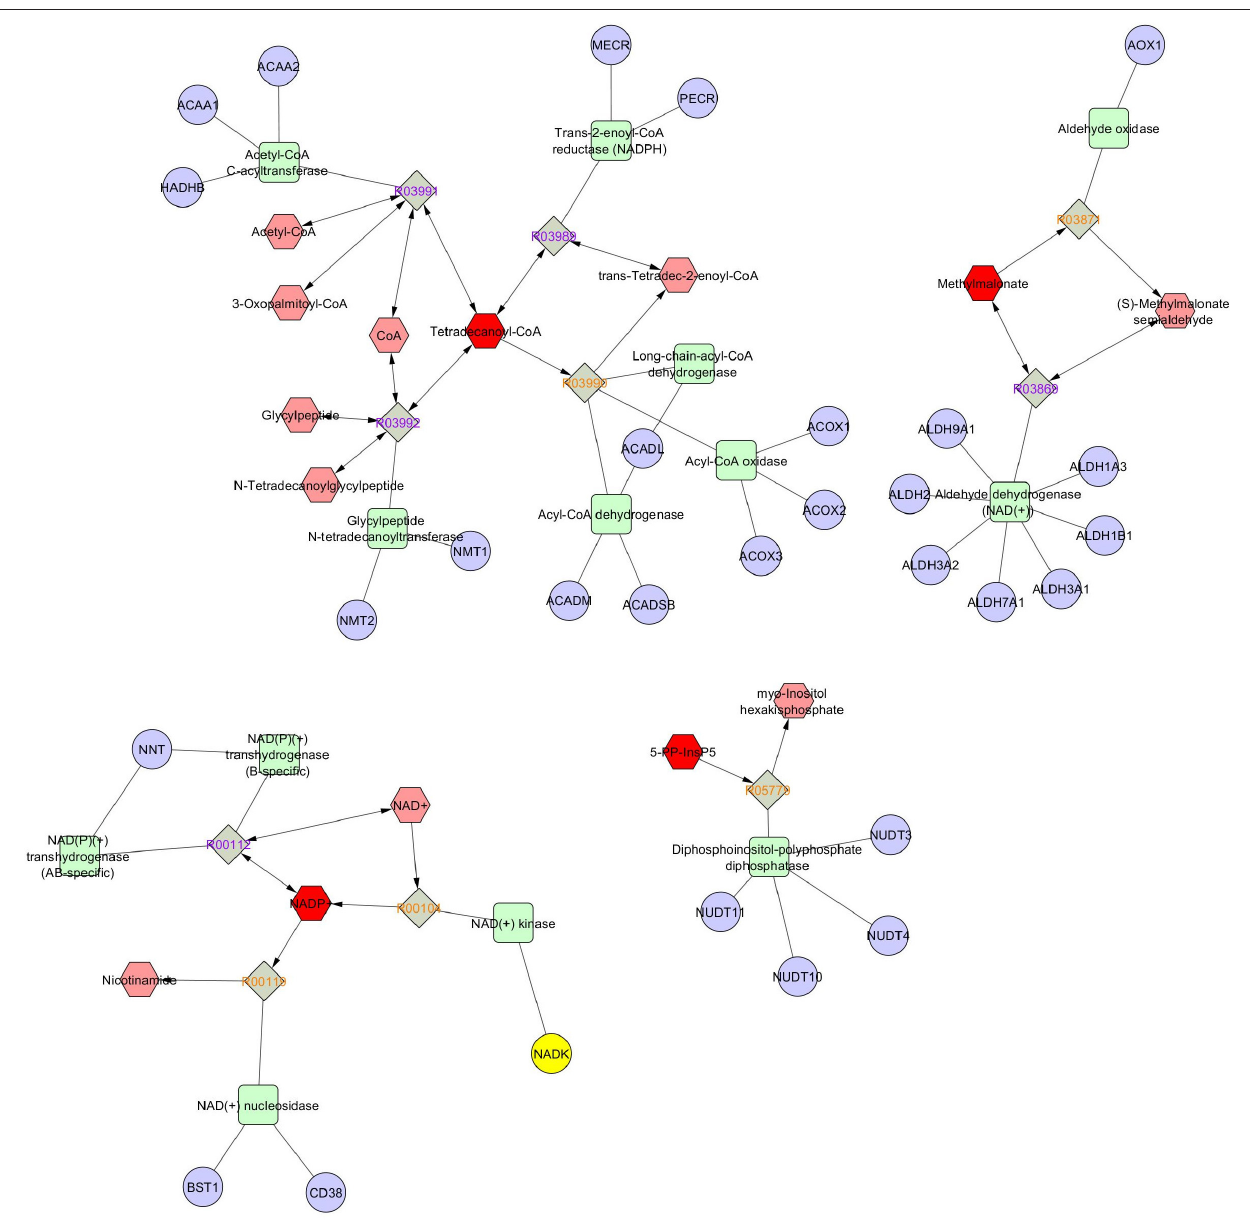
(Mohua et al., unpublished data). We observed a significantly higher level of nitroprusside in a spermatozoal extract of astheno- oligozoospermic bulls. Nitroprusside, a nitric oxide donor, has been shown to have a biphasic role in spermatozoa regulating sperm capacitation, acrosome reaction, and male fertility (36). On the one hand, it was shown that sodium nitroprusside had a positive effect on spermatozoa to counterbalance the increased level of ROS and decreased level of adenosine triphosphate (ATP)/Ca 2 + , whereas, on the other hand, Balercia